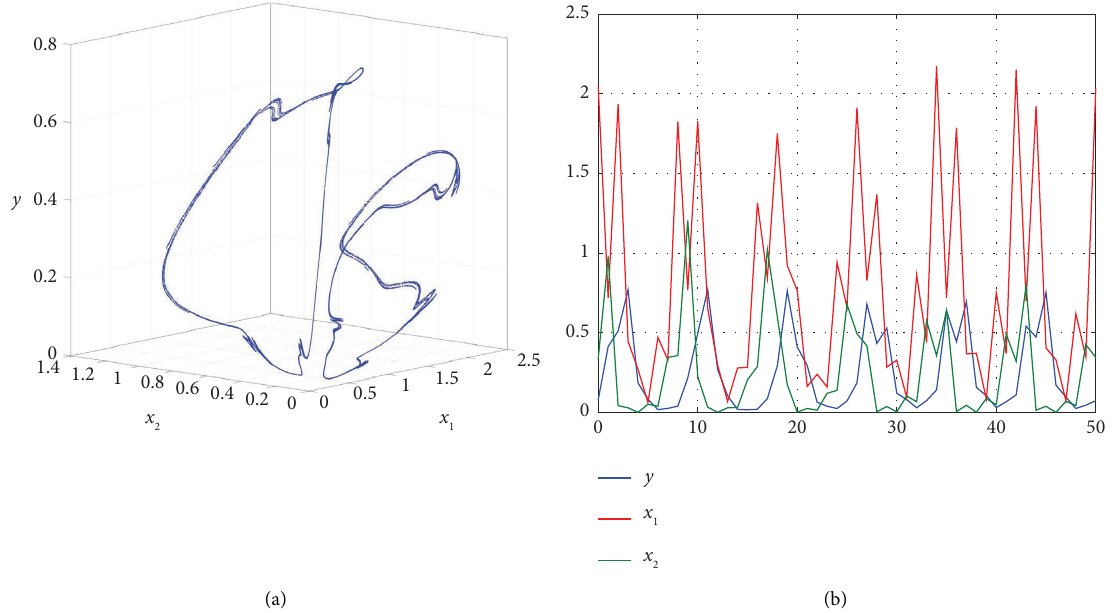
Figure 15: (a) Chaotic dynamics generated by map (39). Parameter values ( μ sponding time